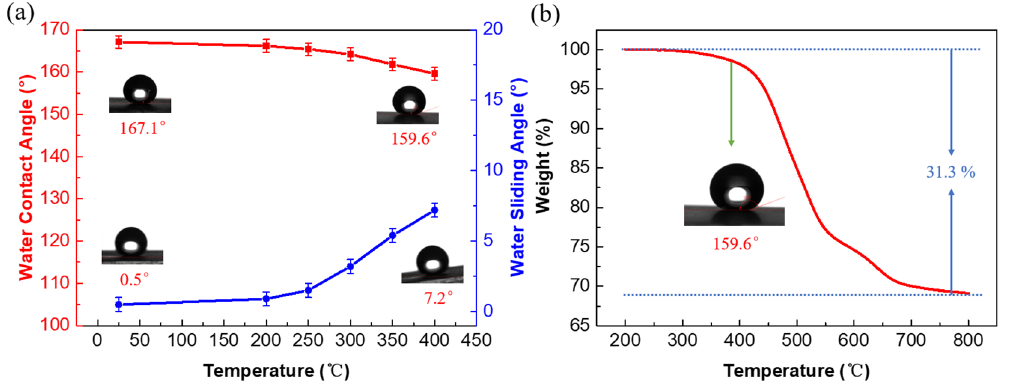
Figure 6. ( a ) The changes of the WCA and WRA of the modified film under heating for 1 h; ( b ) the thermogravimetric analysis of the modified film.